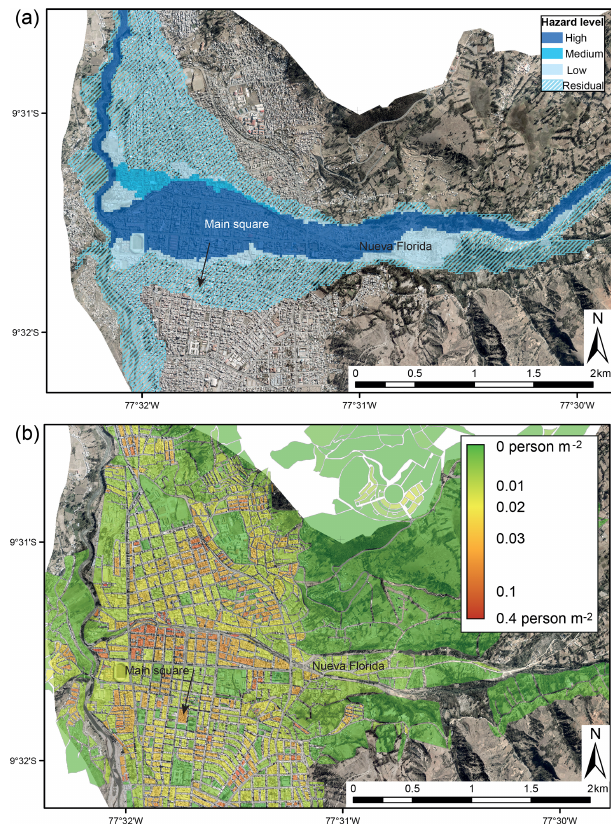
Figure 5. (a) Hazard map for the city of Huaraz as related to GLOFs from lake Palcacocha. The district of Nueva Florida and the main square of the city are indicated (for a more detailed description of the hazard mapping methodology, see the Supplement) (image source: © Google Earth/Maxar Technologies; date of acquisition: 10 Oct 2017). (b) Population distribution for the same extent of Huaraz. Also indicated is the extent of the high-hazard zone (dark blue in a ) (source of population data: